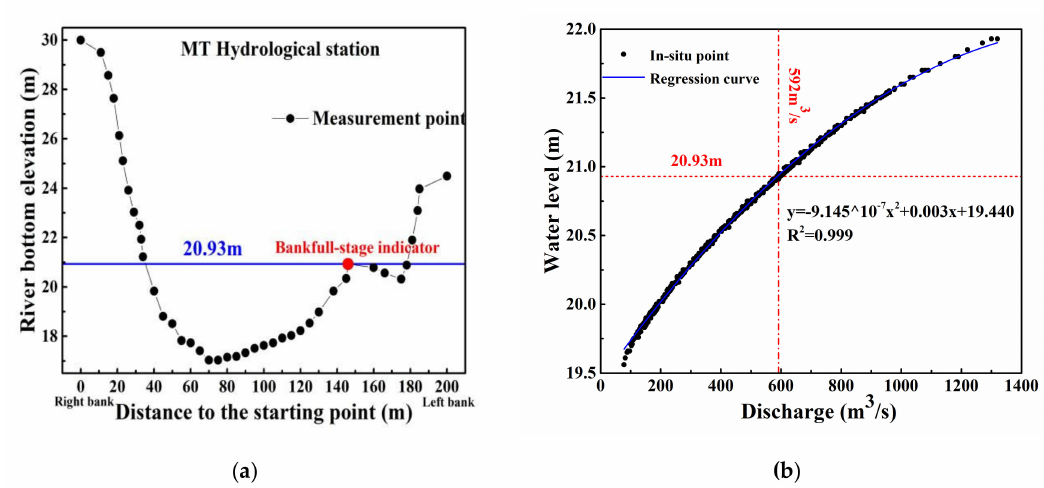
Figure 3. Cross-section morphology of the year 2015 ( a ) and the water level-discharge rating curve ( b ) of a typical cross section at the Mentang hydrological